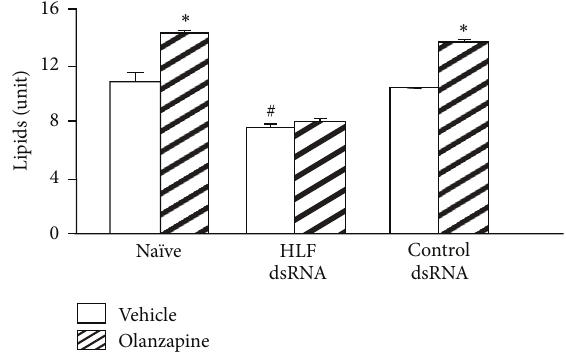
Figure 7: HLF RNAi prevents the adipogenic effect of olanzapine in mouse 3T3-L1 cells. Olanzapine and vehicle treatments were initiated 24h after the initiation of transfection and conducted for the next 24 h. At the end of the treatment, cells were assayed for lipid content( ∗ 𝑃 < 0.001 versuscorrespondingvehicle; # 𝑃 < 0.001 versus na¨ıve and control dsRNA transfection; 𝑛 = 3 ; mean ± standard error